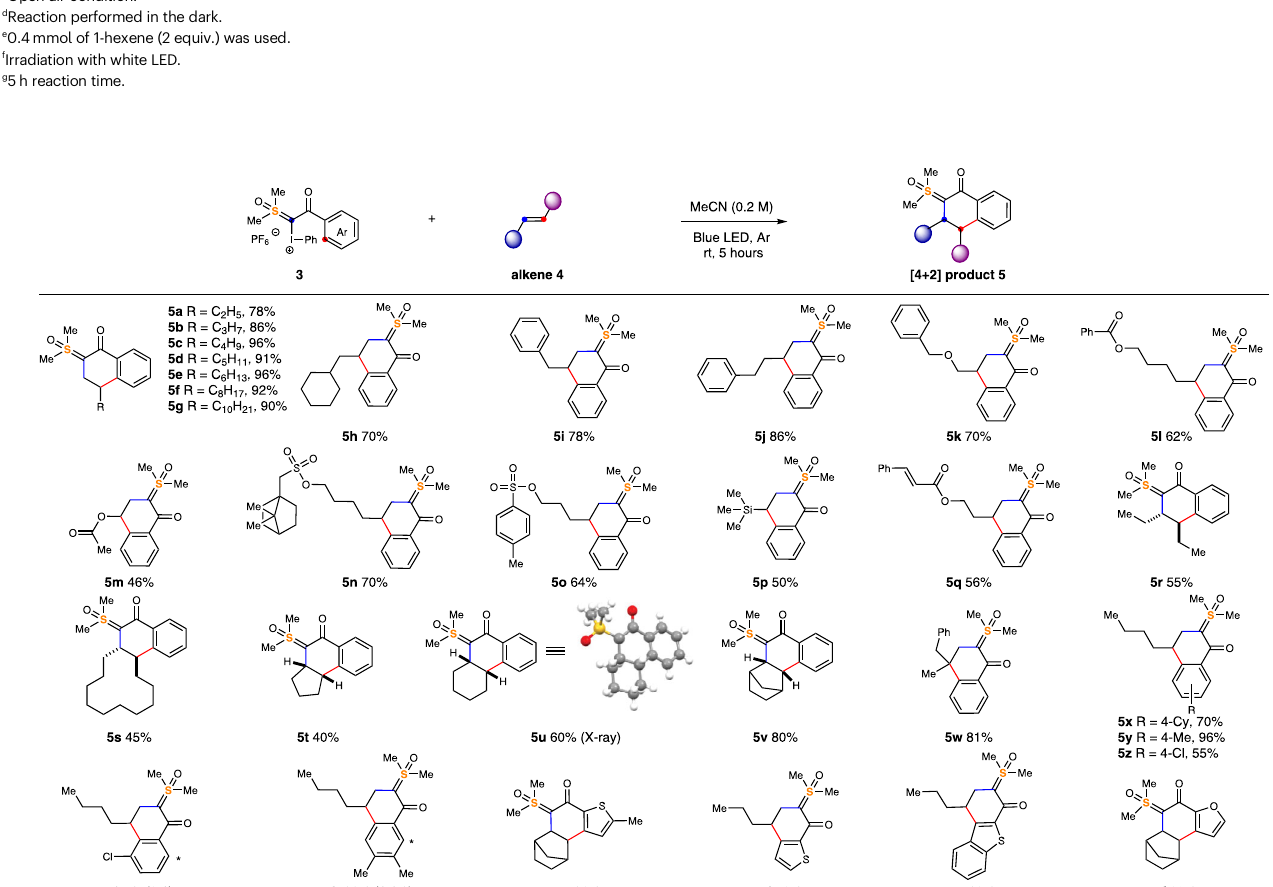
Fig. 3 | The scope of visible-light-mediated [4+2] cycloaddition with aliphatic alkenes. Reactions were performed by mixing alkene (0.8mmol, 4 equiv.) and reagent 3 (0.2mmol, 1 equiv.) in 1.0mL of MeCN at room temperature, under